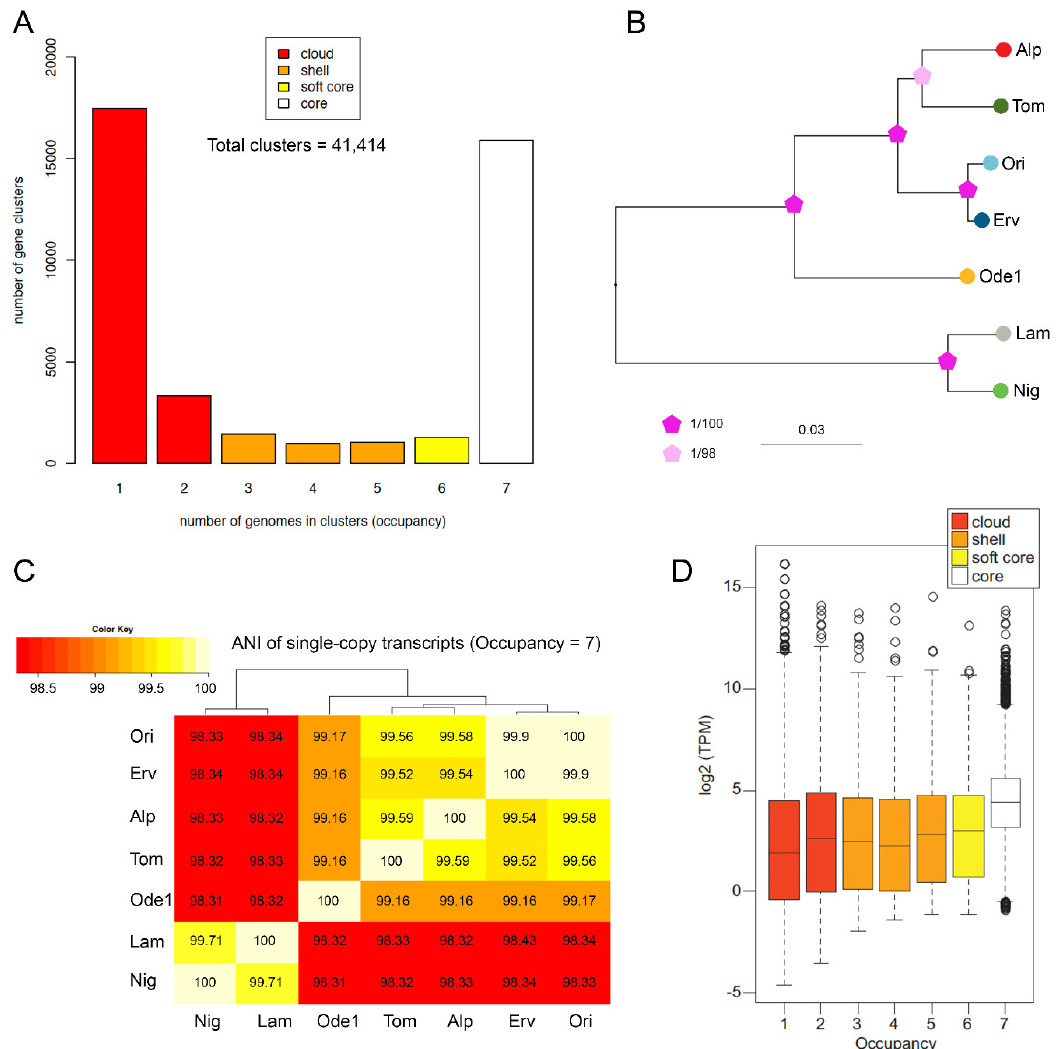
Figure 6. ( A ) Pan-transcriptome distribution of the different orthologous clusters related to the occupancy or the number of taxa present in each cluster. For instance, core loci are found in all seven accessions and hence have occupancy = 7. ( B ) Best maximum-likelihood pan-transcriptome phylogeny for the genus Lens using concatenated nucleotide sequences. The branch tips are colored according to the color code maintained for the accessions. The scale bar represents the number of expected substitutions per site under the best-fitting GTR + ASC + F model found. The values on the left of the legend correspond to approximate Bayes branch support values, and those to the right correspond to the UFBoot values. ( C ) Heatmap of average nucleotide identity (ANI) summarizing intra-specific genetic diversity. The dendrograms were computed by complete linkage clustering and Euclidean distances. ( D ) Mean expression of CDS in transcripts per million (TPM) as a function of their occupancy. Alp ( culinaris ), Ori ( orientalis ), Tom ( tomentosus ), Erv ( ervoides ), Lam ( lamottei ), Nig ( nigricans ), Ode1 and Ode2 ( odemensis